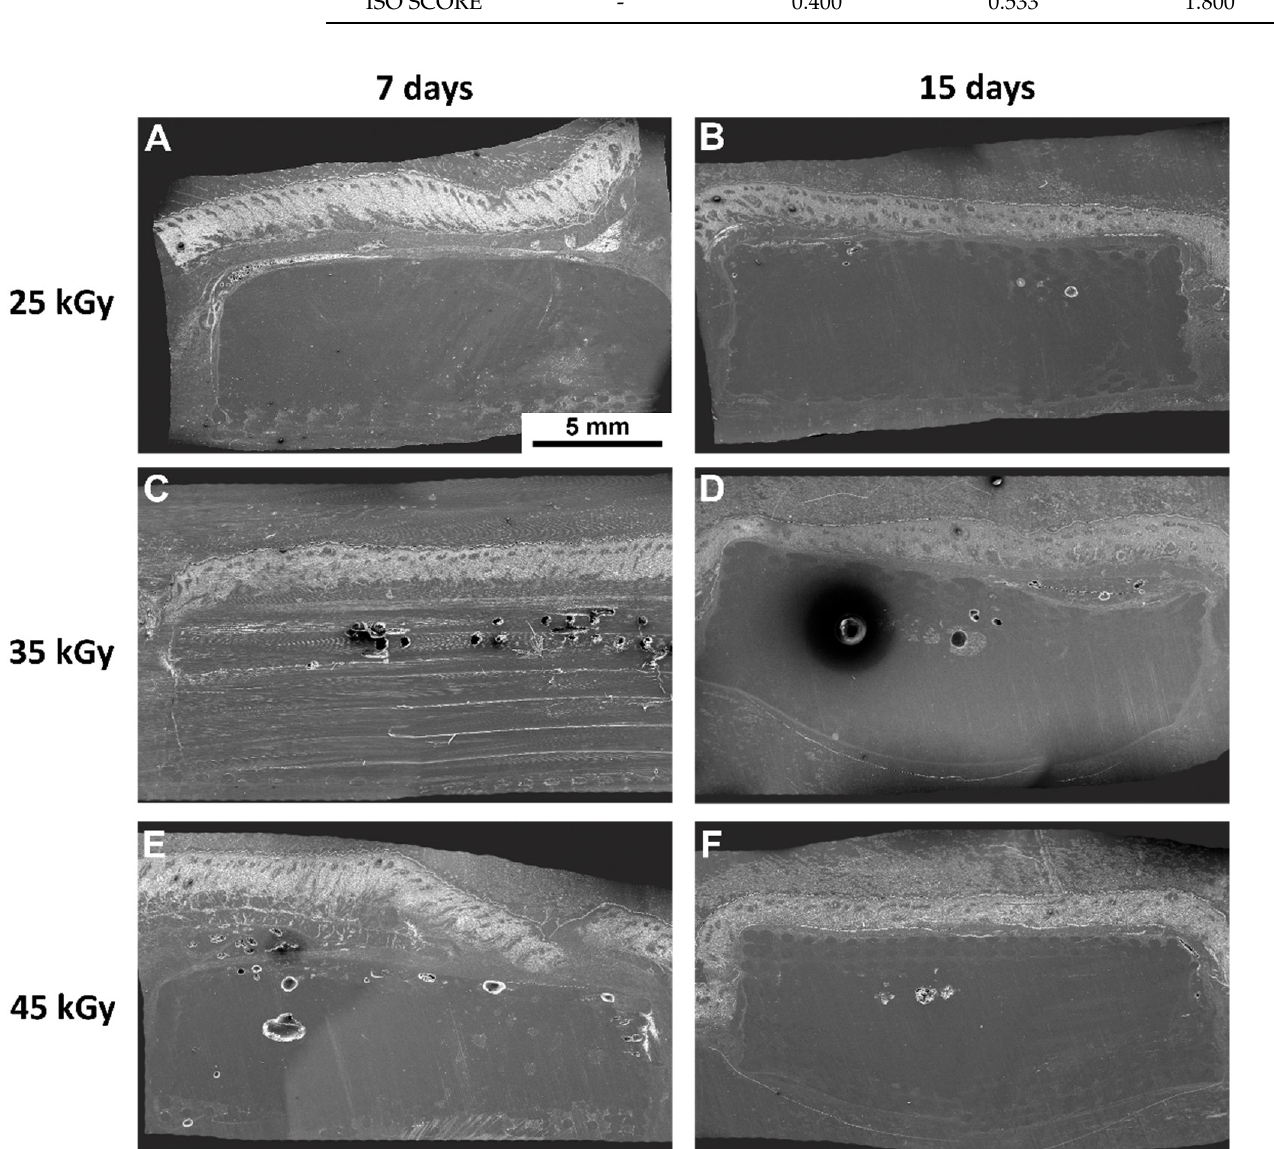
Figure 5. SEM images of the subcutaneously implanted 3D PCL devices in the rat animal model. Representing the left panel and the right panel, 7 days, and 15 days recovery time, respectively. ( A , B ) devices were sterilized with 25 kGy gamma radiation, ( C , D ) with 35 kGy and ( E , F ) with 45 kGy. Magnification of 20× and scale bar 5 mm.